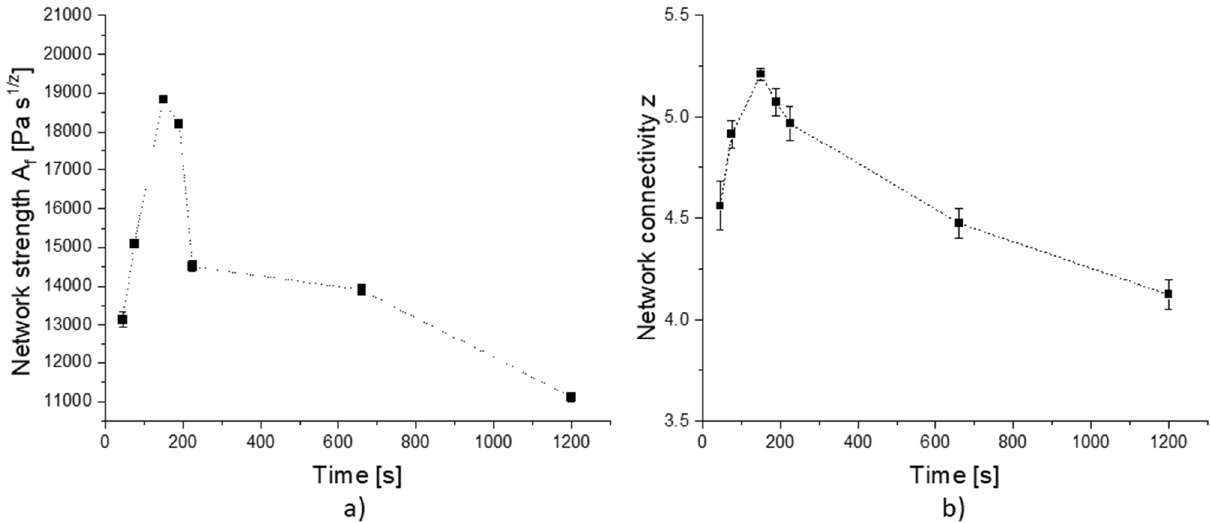
Figure 3. ( a ) Fitting parameter Af and ( b ) parameter z from power-law fitting the frequency sweep results of dough produced in a Z-Kneader according to Gabriele et al. [19]. Means are shown with standard deviation (n = 3).